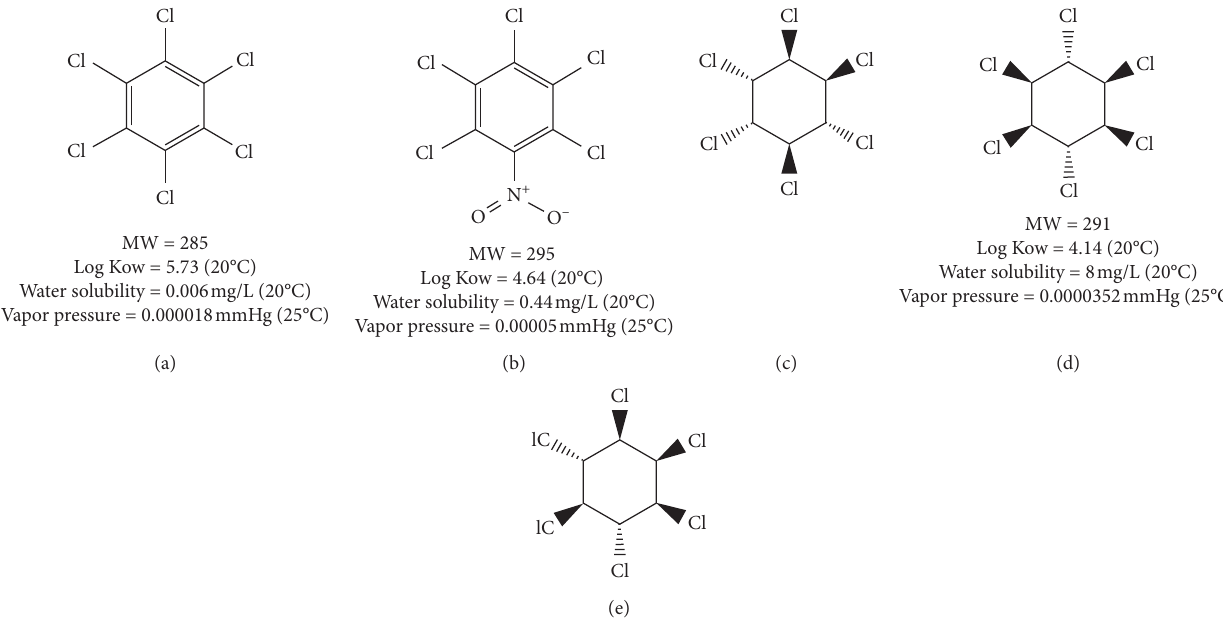
Figure 1: Structures and properties of (a) hexachlorobenzene, (b) pentachloronitrobenzene, (c) α -BHC, (d) c -BHC, and (e) δ -BHC. Referential pesticide properties are at http://www.chemspider.com/Default.aspx(accessed 24 October 2019).